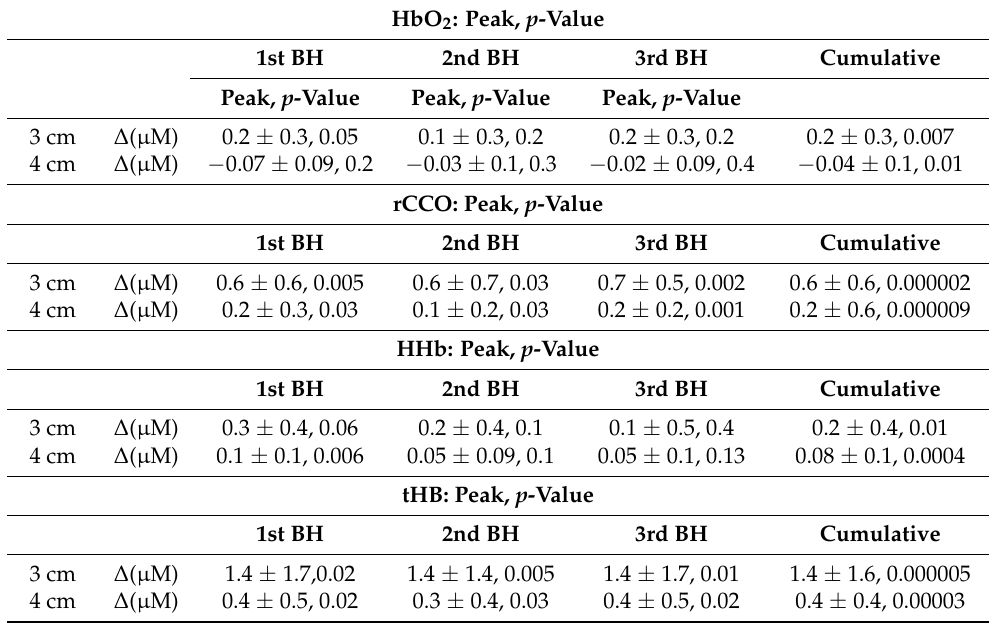
Table 2. Cross-subject average peak magnitudes and p -values obtained from the two-layer regression analysis. The peak magnitudes were measured from the 20 s averaged values before